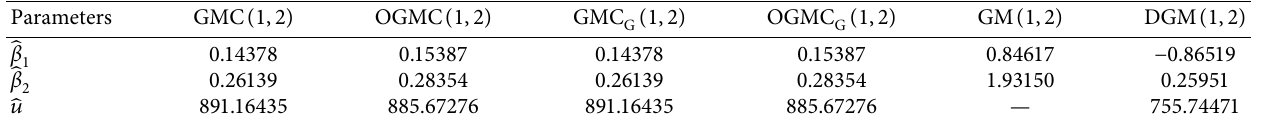
Table 2: Estimated parameter values of six competing models in case one.